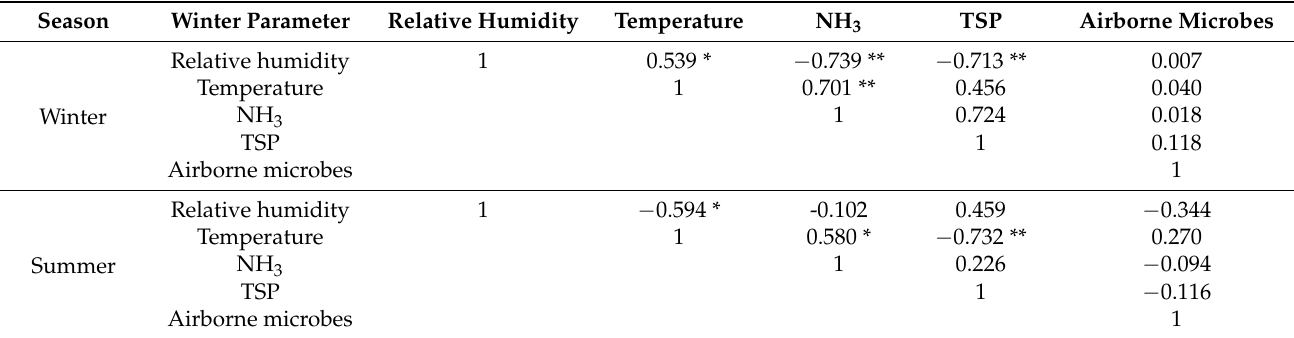
Table 4. Correlation coefficients between air pollutant concentrations and indoor environmental variables during summer and winter.